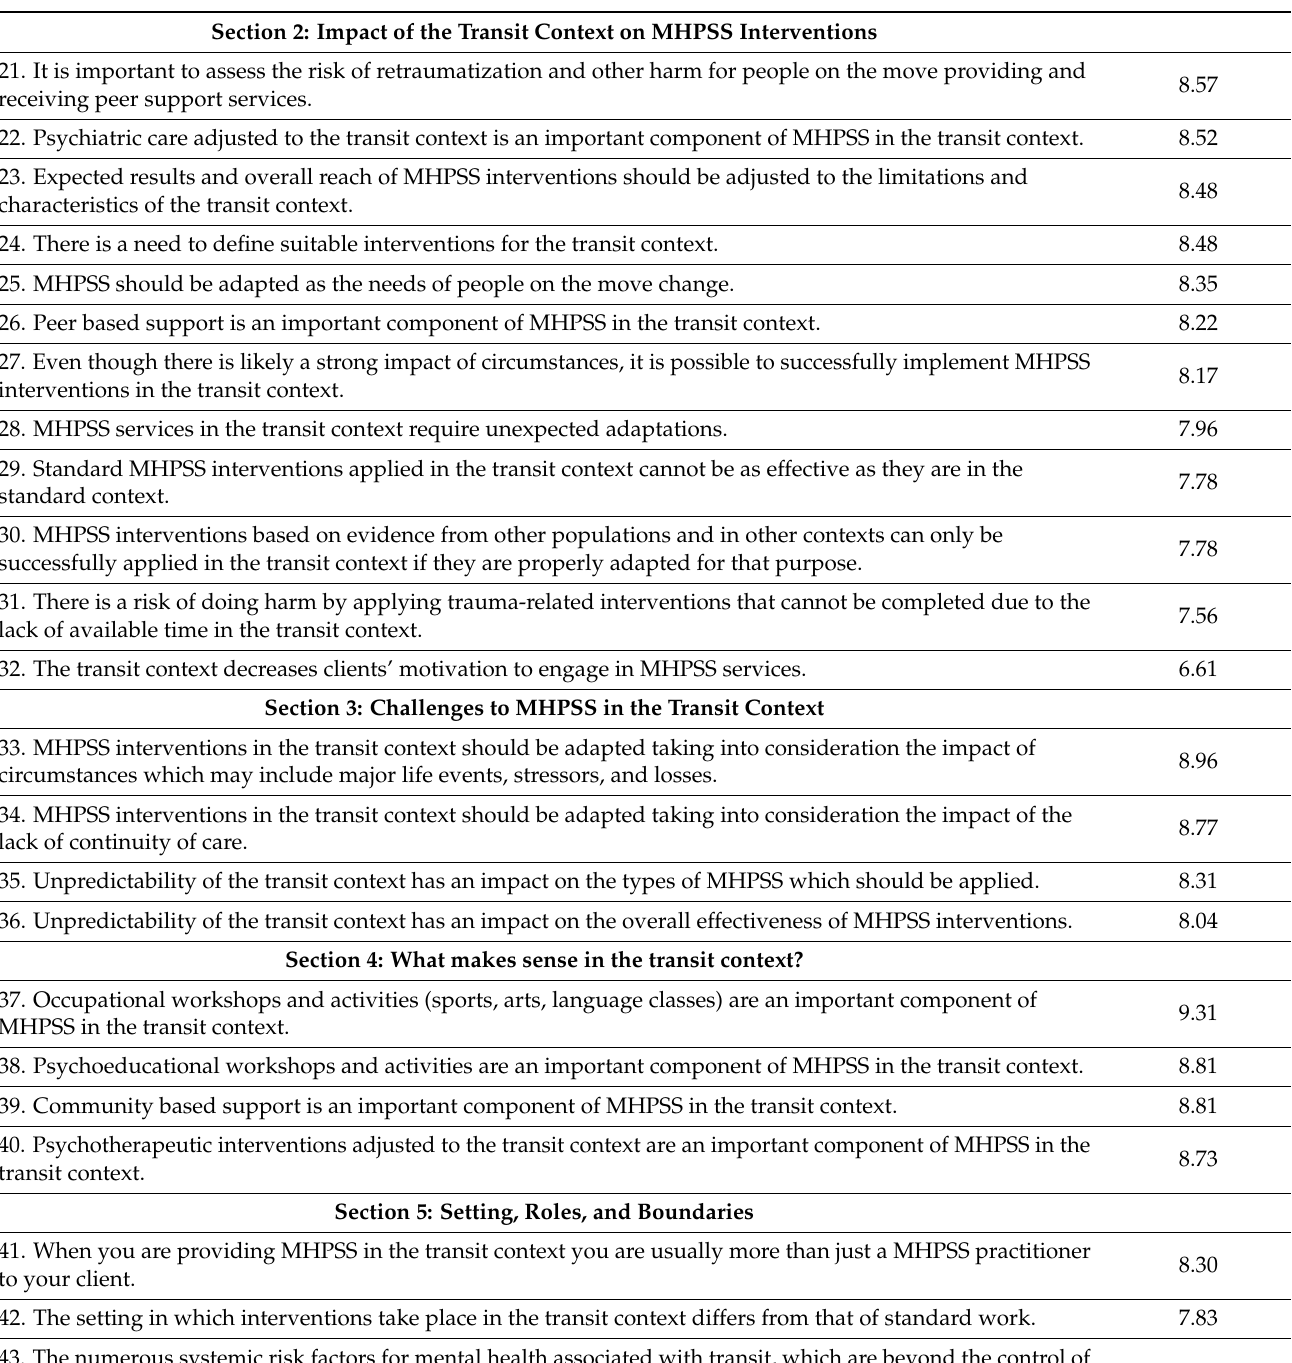
Section 2: Impact of the Transit Context on MHPSS